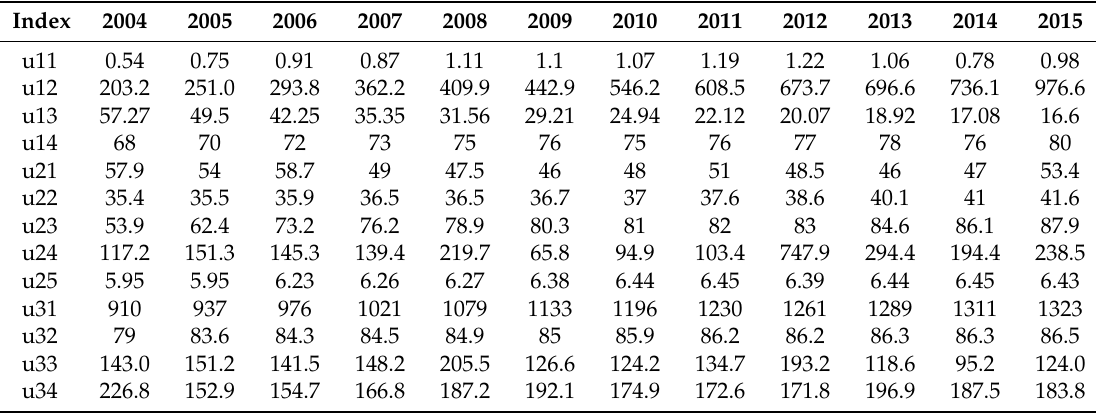
Table 6. The actual data corresponding to each index from 2004 to 2015.